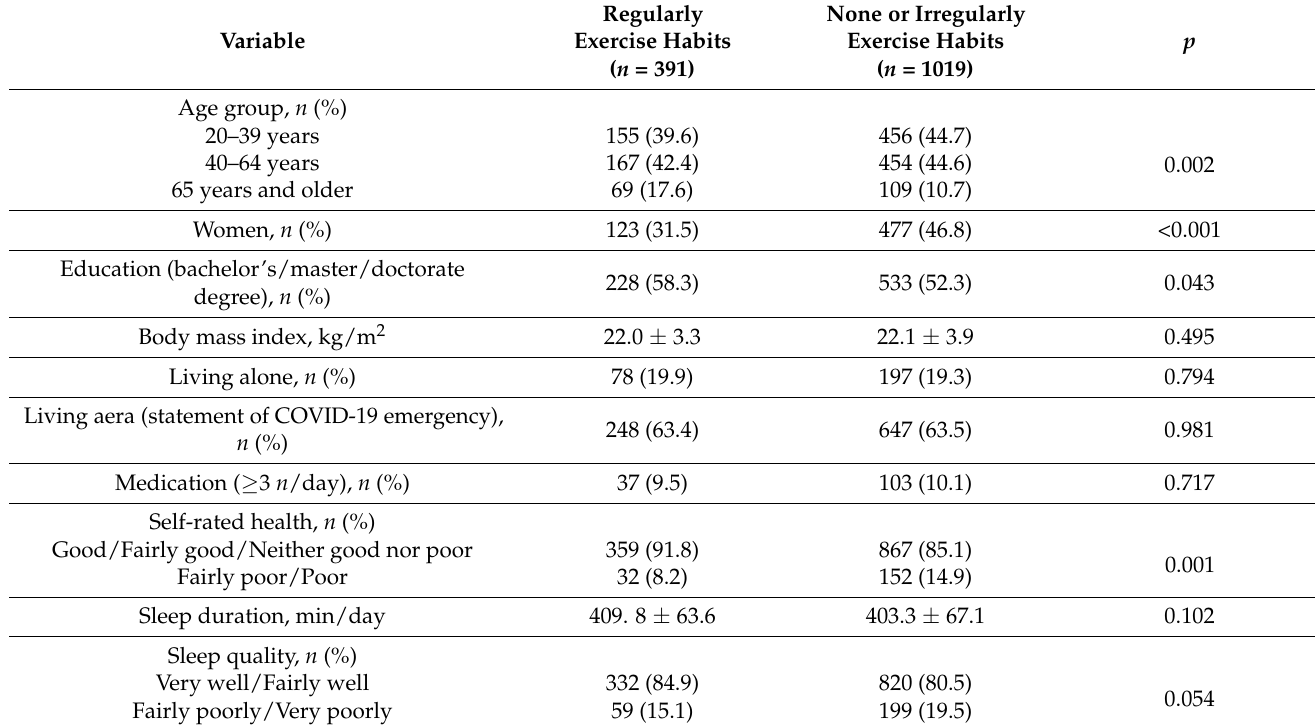
Table 2. Comparisons of characteristics, self-rated health, sleep duration, and sleep quality between participants with regularly exercise habits and those